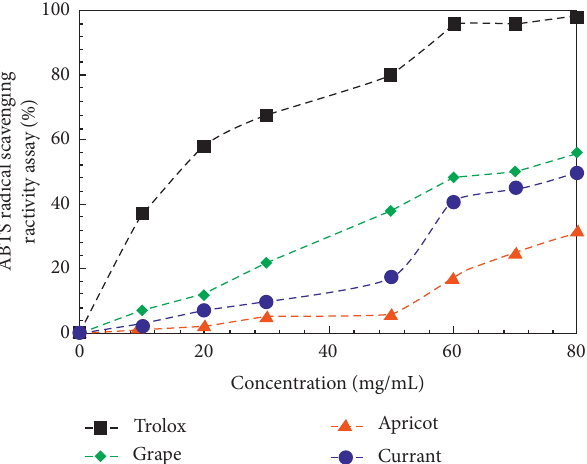
Figure 9: ABTS radical scavenging activity of the aqueous black currant, apricot, and grape pomace extracts.